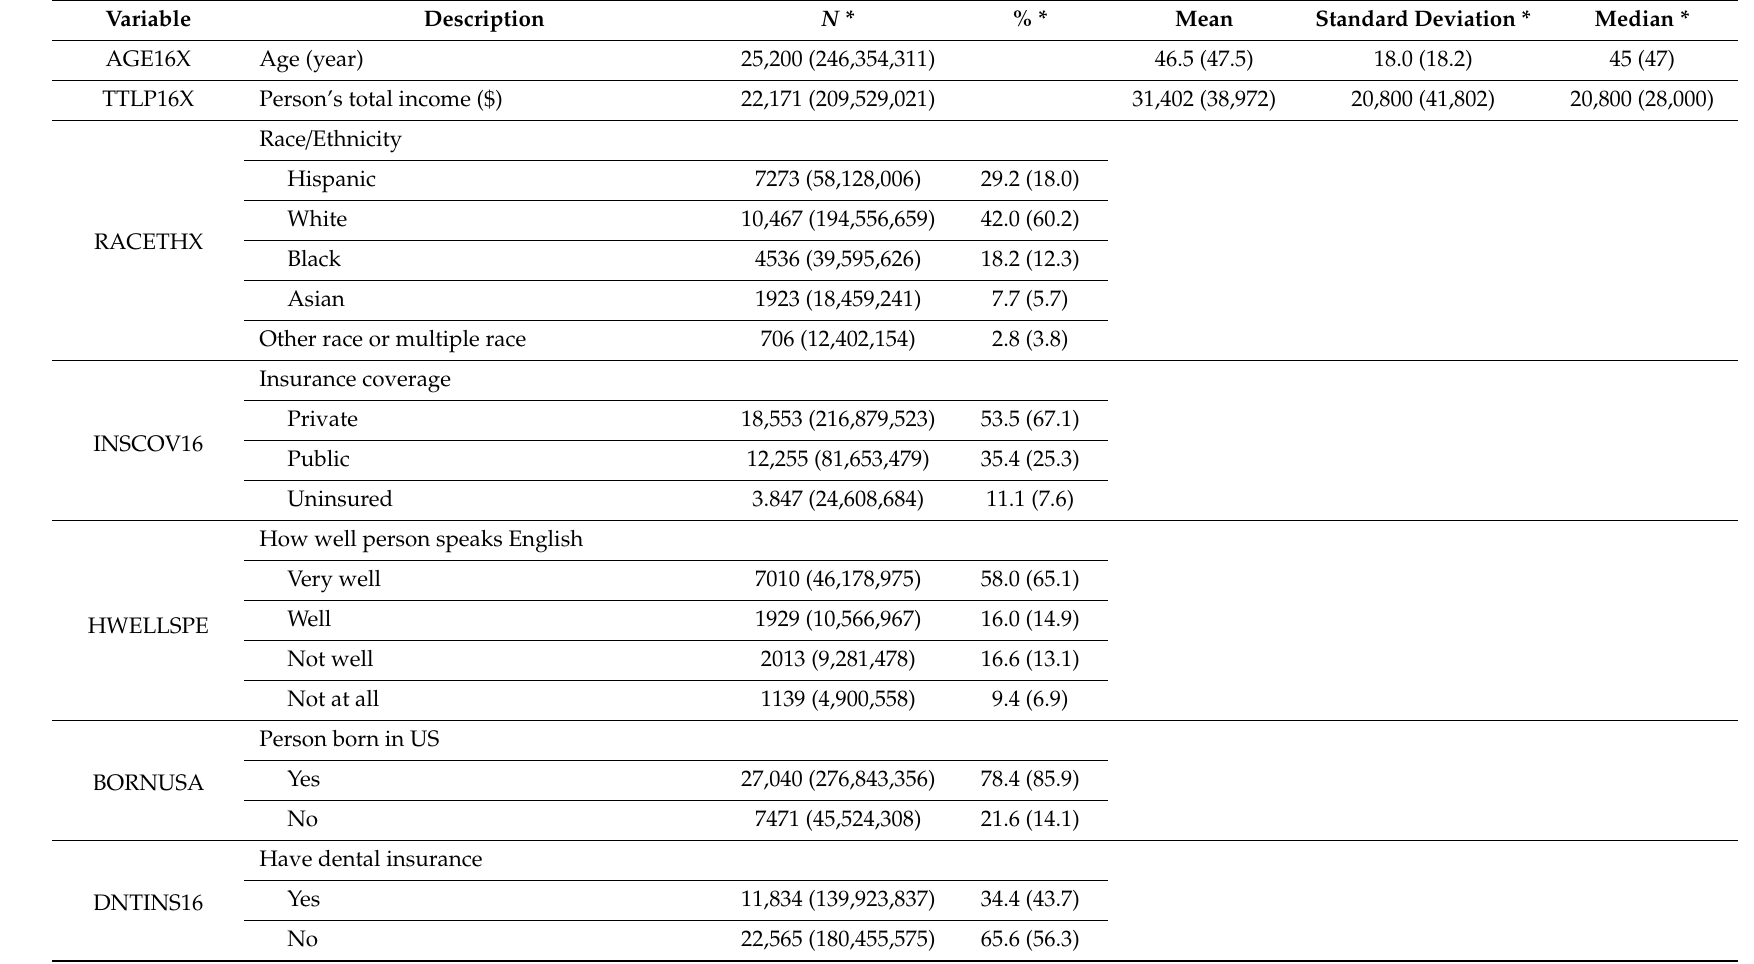
Table 1. Demographic